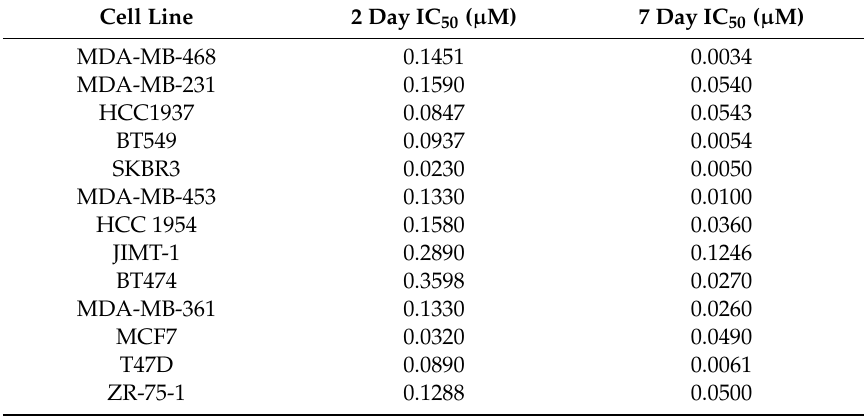
Figure 1. CDK7 RNA expression in breast cancer patient tumor samples. Association of CDK7 RNA expression with Relapse Free Survival (RFS) in microarray data from 3,951 breast cancer patient samples in all breast cancer patients ( A ), luminal-A patients ( B ), luminal-B patients ( C ), basal patients ( D ), and HER2 + patients ( E ), determined using KM-plotter online survival analysis tool [19]. Table 1. THZ1 IC 50 data in breast cancer cell line panel after 2 days and 7 days of treatment with increasing concentrations of THZ1. IC 50 values were determined using CompuSyn